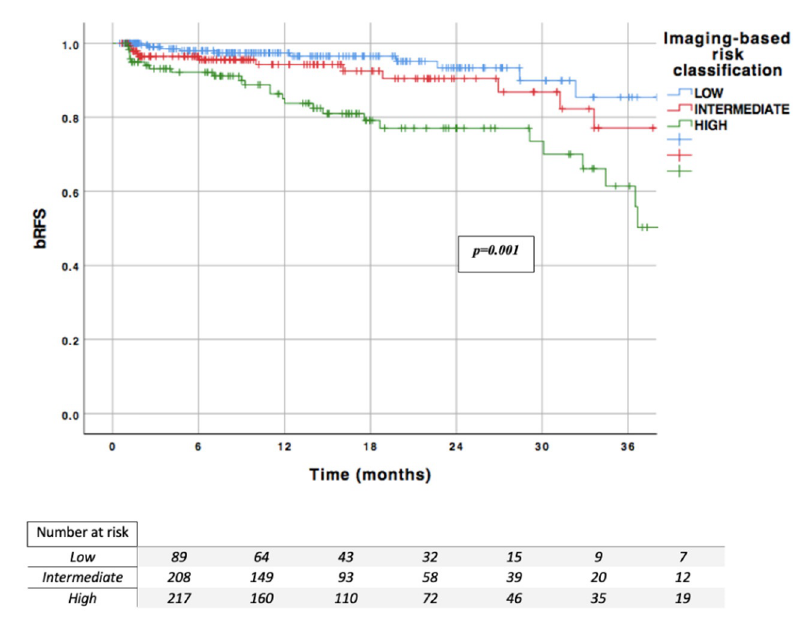
Figure 3. Imaging-based risk classification; bRFS: biochemical recurrence free Figure 2. Imaging-based risk classification; bRFS: biochemical recurrence free survival.